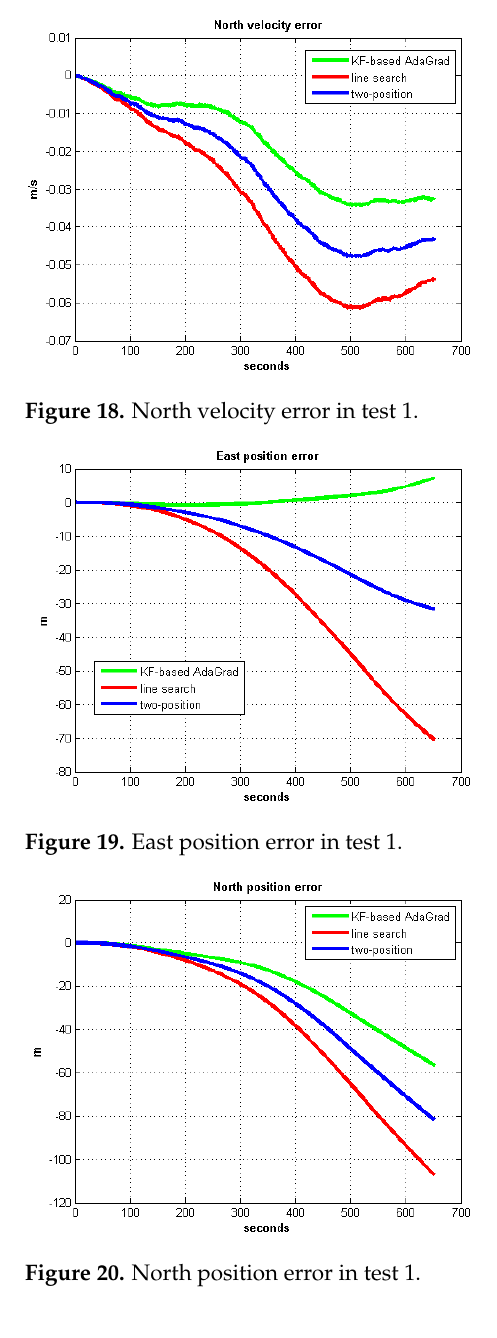
Figure 17. East velocity error in test 1.